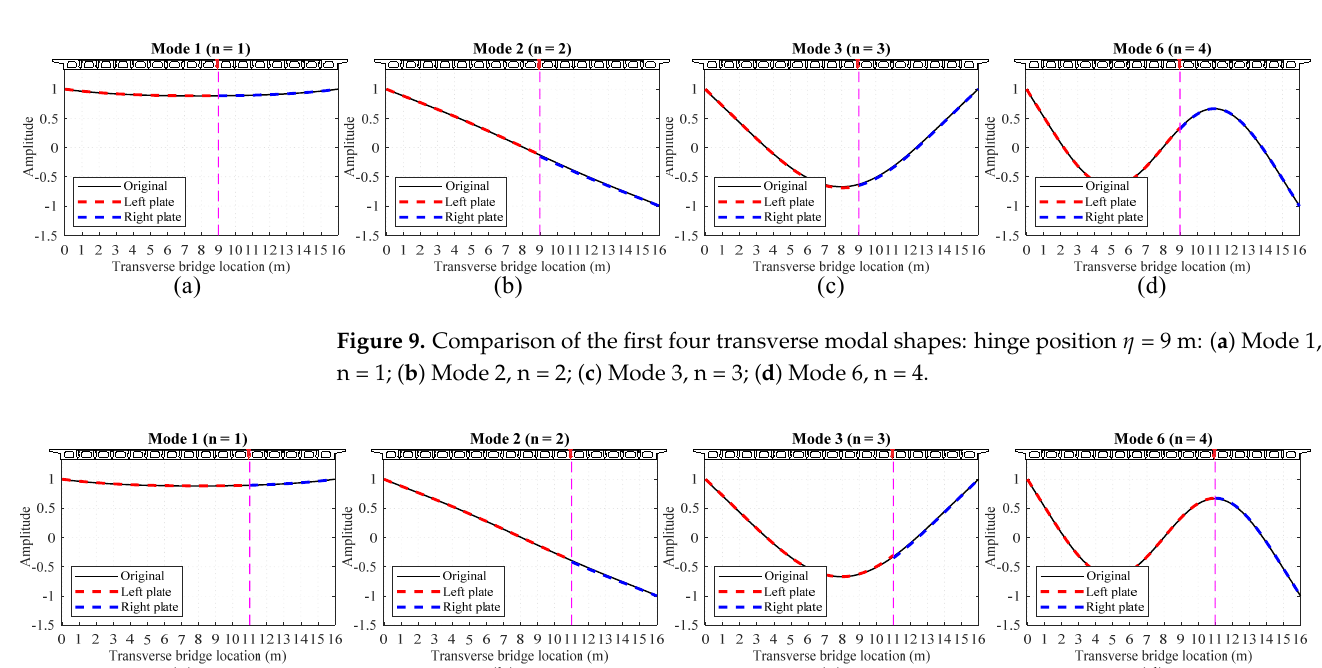
(d) Figure 11. Comparison of the first four transverse modal shapes: hinge position η = 13 m: ( a ) Mode 1, n = 1; ( b ) Mode 2, n = 2; ( c ) Mode 3, n = 3; ( d ) Mode 6, n = 4. (a) (d) Figure 12. Comparison of the first four transverse modal shapes: hinge position η = 15 m: ( a ) Mode 1, n = 1; ( b ) Mode 2, n = 2; ( c ) Mode 3, n = 3; ( d ) Mode 6, n = 4. It can be seen from Figure s 9–12 that the local modal shapes represented by “plate L” and “plate R” can also well match the modal shapes of the original structure when considering a setting of equivalent elastic boundaries at different positions. When the elas- tic boundary and the free boundary gradually approach, the error of the local modal shape will be relatively larger than that when 8m η =